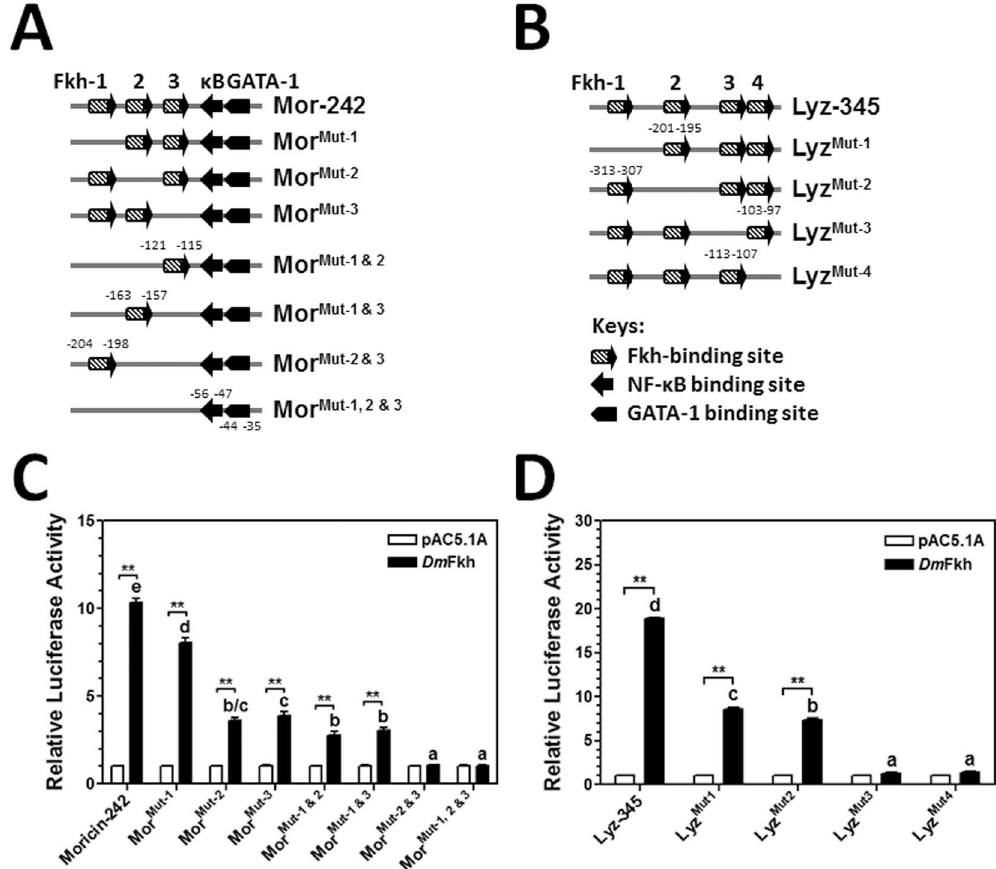
Figure 5. Identification of active Fkh-binding sites in M. sexta moricin and lysozyme promoters. ( A , B ) Schematic diagrams of the truncated Mor-242 ( A ) and Lyz-345 ( B ) promoters. Fkh-1, 2, 3, 4 indicate the predicted Fkh-binding sites 1, 2, 3, 4; κ B and GATA-1 indicate the NF- κ B and GATA-1 binding sites in the moricin promoter. Mut-1, − 2, − 3, − 4 indicate the mutation of Fkh-binding sites 1, 2, 3, 4; Mut-1 & 2, Mut-1 & 3, Mut-2 & 3, and Mut-1, 2 & 3 indicate the mutations of Fkh-binding sites 1 and 2, 1 and 3, 2 and 3, as well as 1, 2 and 3, respectively. ( C, D ) Activation of Mor-242 and Lyz-345 promoters by recombinant DmFkh. The relative luciferase activities of Mor-242 and its Fkh-binding site mutant promoters ( C ), Lyz-345 and its Fkh- binding site mutant promoters ( D ) activated by recombinant DmFkh in S2 cells were determined by Dual- Luciferase ® Reporter Assay System as described in the Materials and Methods. Bars represent the mean of three independent measurements ± SEM. For the relative luciferase activity among different promoters activated by DmFkh (comparing the solid bars), identical letters are not significant difference (p > 0.05) while different letters indicate significant difference (p < 0.05). For the activity of the same promoter after overexpression of DmFkh (comparing the solid and open bars for each promoter), the significance of difference was also determined by an unpaired t-test ( * p < 0.05; ** p <